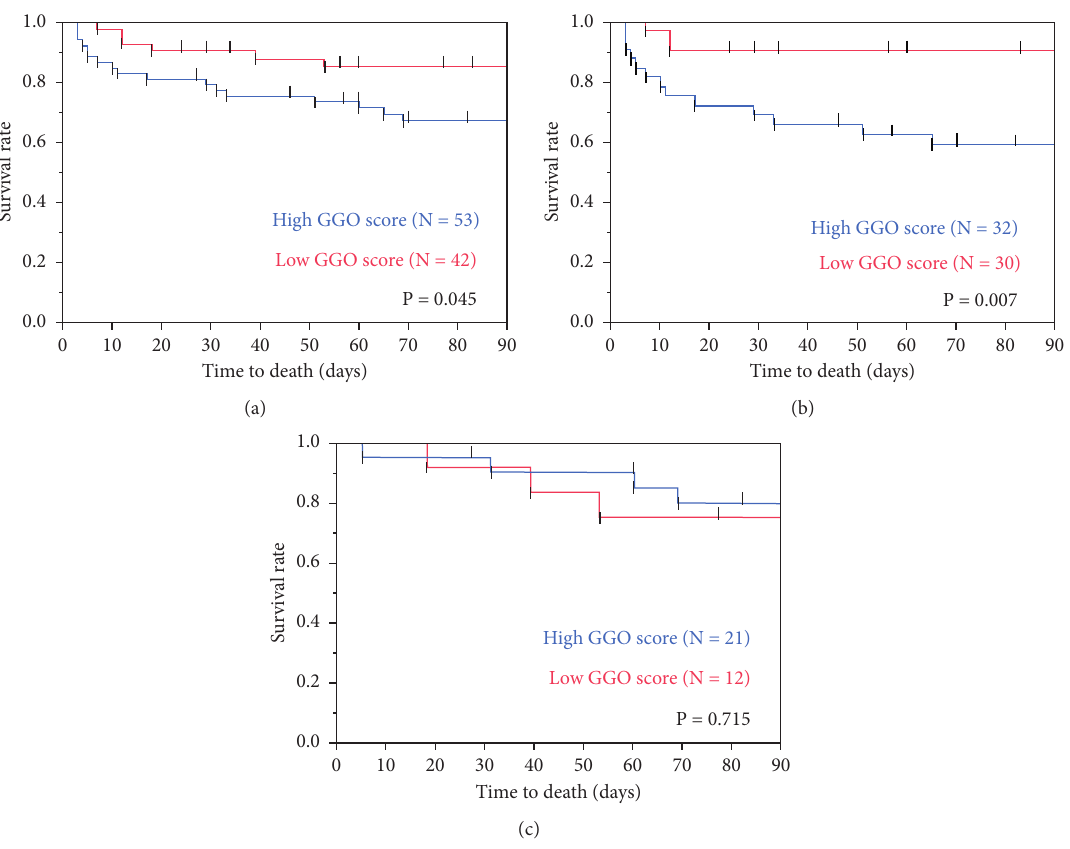
Figure 1: Comparison of patients with high and low GGO scores. The 95 patients assigned to groups with a low GGO ( N � 42) or a high GGO ( N � 53) score based on the optimal cutoff (10 points). Log-rank tests show that Kaplan–Meier survival curves of these groups differ significantly in patients with AE of idiopathic ILDs and overall patients, but not in those with AEs of secondary ILDs. AE, acute ex- acerbation; GGO, ground-glass opacity; ILD, interstitial lung disease. (a) Overall. (b) Idiopathic. (c)